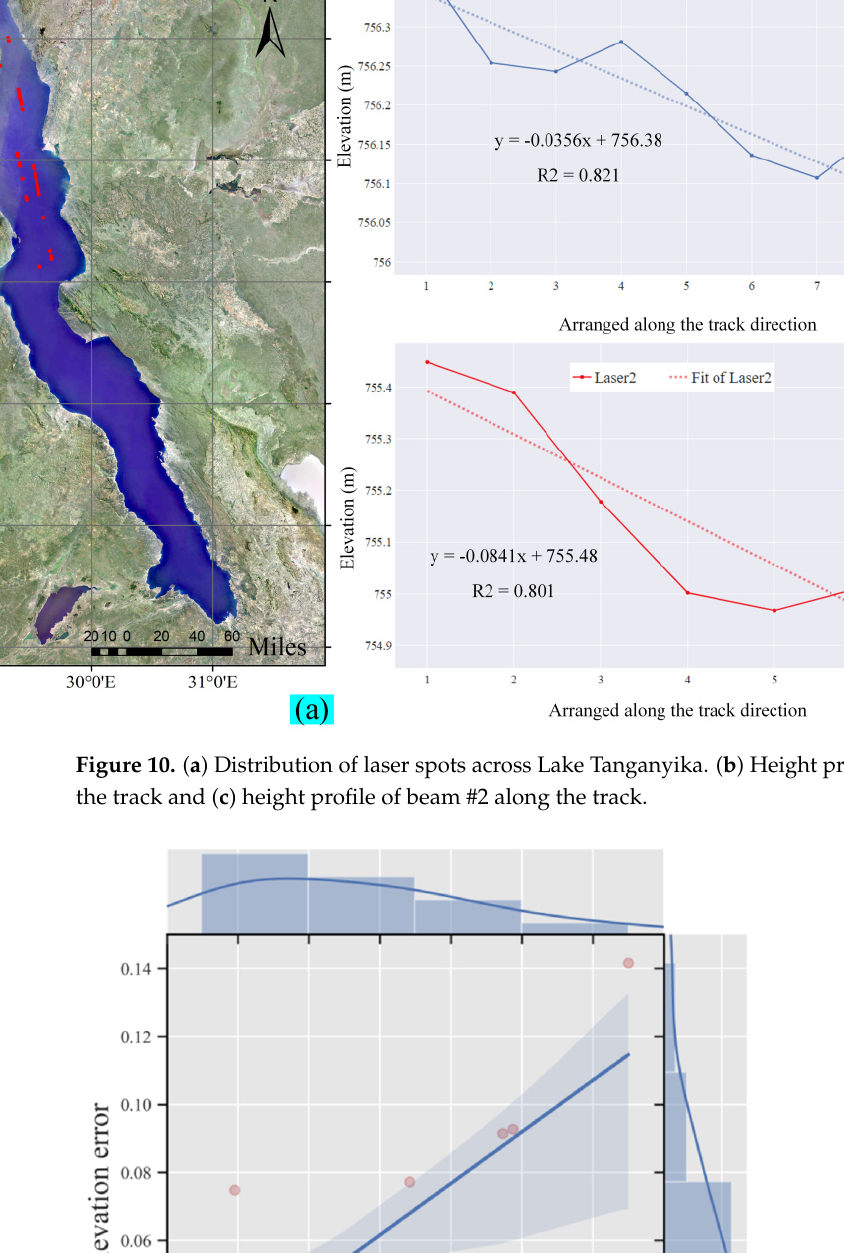
Figure 10. ( a ) Distribution of laser spots across Lake Tanganyika. ( b ) Height profile of beam #1 along the track and ( c ) height profile of beam #2 along the track.